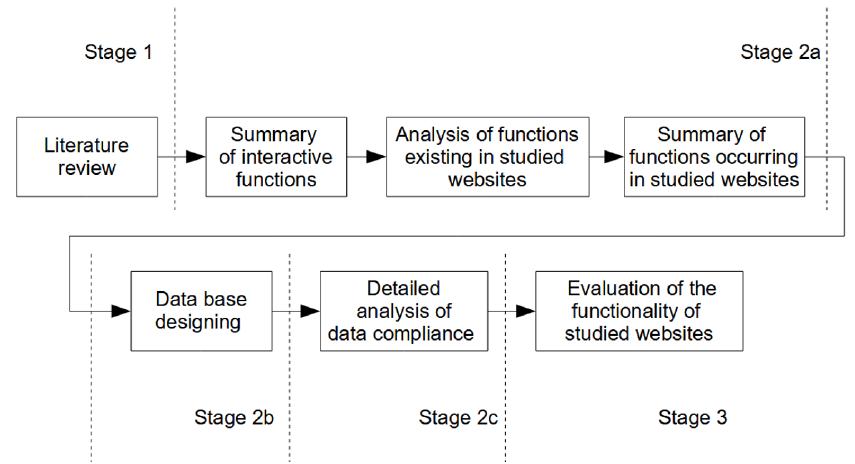
Fig. 5. Research methodology (source: own